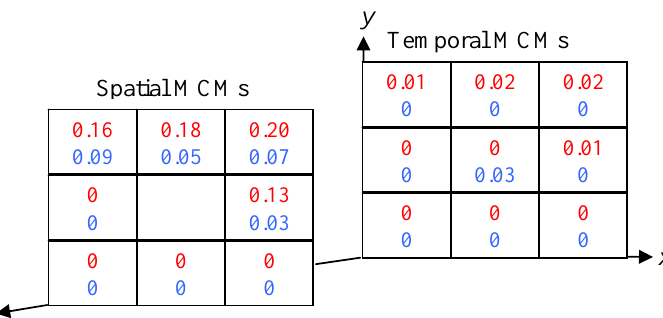
Fig 5: Feature weights obtained using the FFW approach using the GA feature weighting method. Along each clique, the weight of magnitude and direction MCMs are marked in red and blue